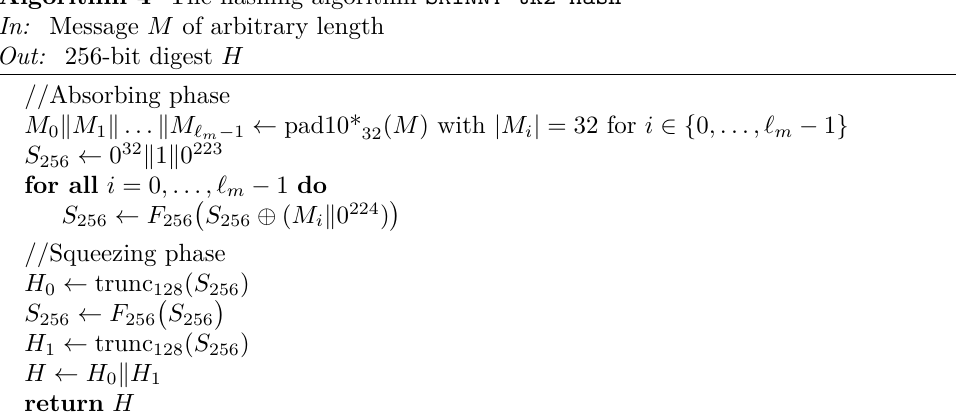
Algorithm 4 The hashing algorithm